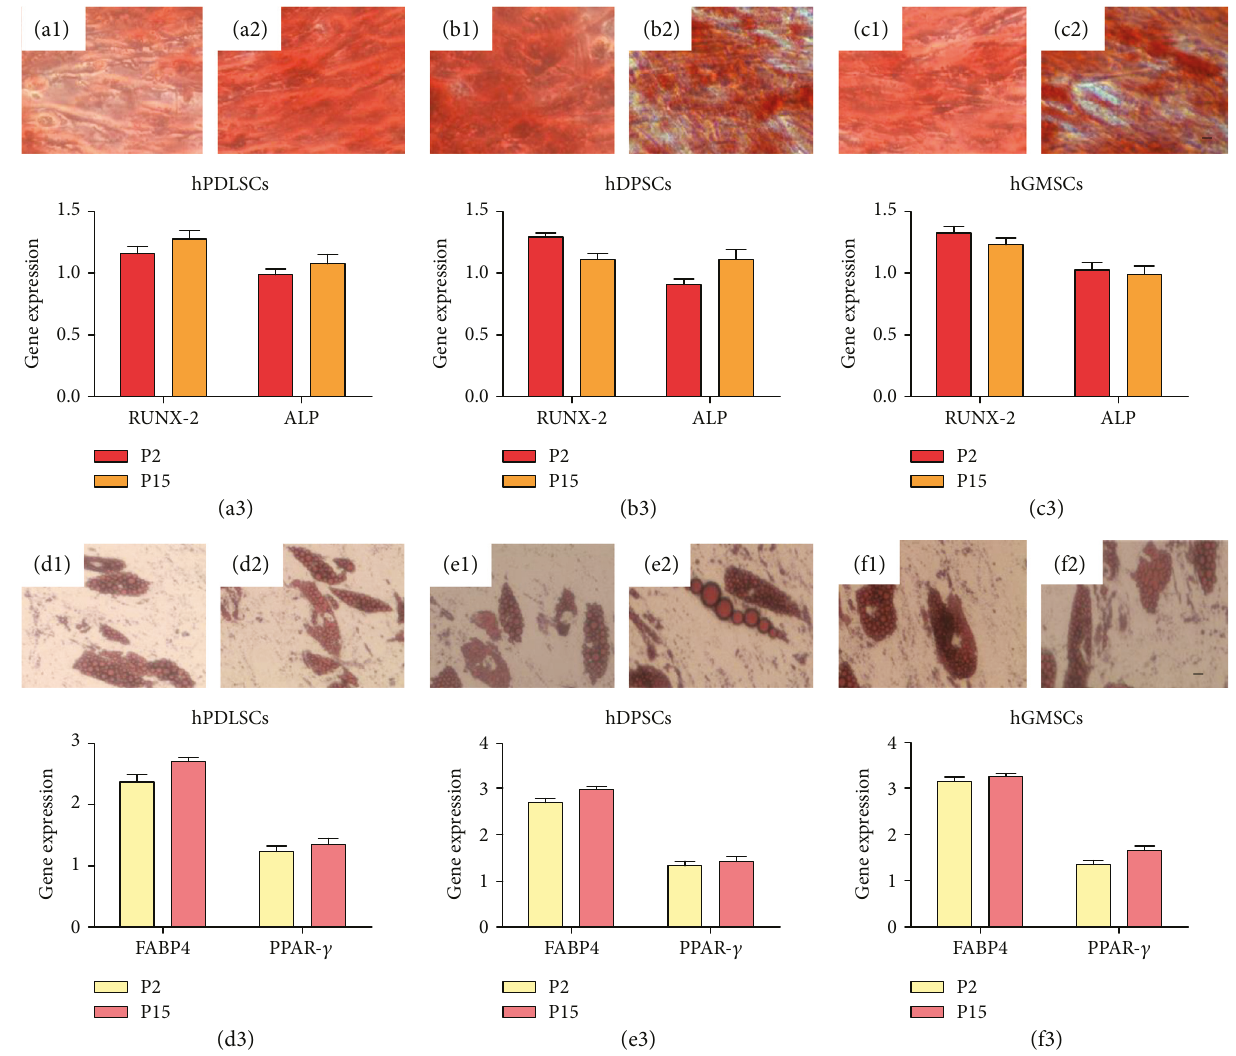
Figure 2: Mesengenic di ff erentiation potential. hPDLSCs, hDPSCs, and hGMSCs induced to osteogenic commitment, stained with alizarin red S solution at P2 (a1, b1, and c1) and P15 (a2, b2, and c2) showed no statistical signi fi cative di ff erences among two di ff erent culture stages. RUNX-2 and ALP expressions con fi rm light microscopy observations for osteogenic commitment (a3, b3, and c3). Adipogenic induction analyzed by oil red solution staining demonstrates the presence of lipid vacuoles at cytoplasmic level in cells cultured at early (d1, e1, and f1) and late passages (d2, e2, and f2). Both PPAR γ and FABP4 showed no statistical di ff erences after 28 days of culture, under di ff erentiation conditions, at P2 and P15 (d3, e3, and f3). Mag.: 10x, bars: 10 μ